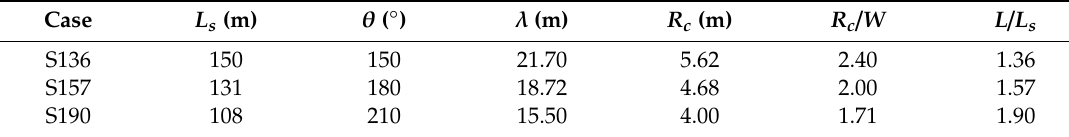
Table 1. Geometric parameters of meandering